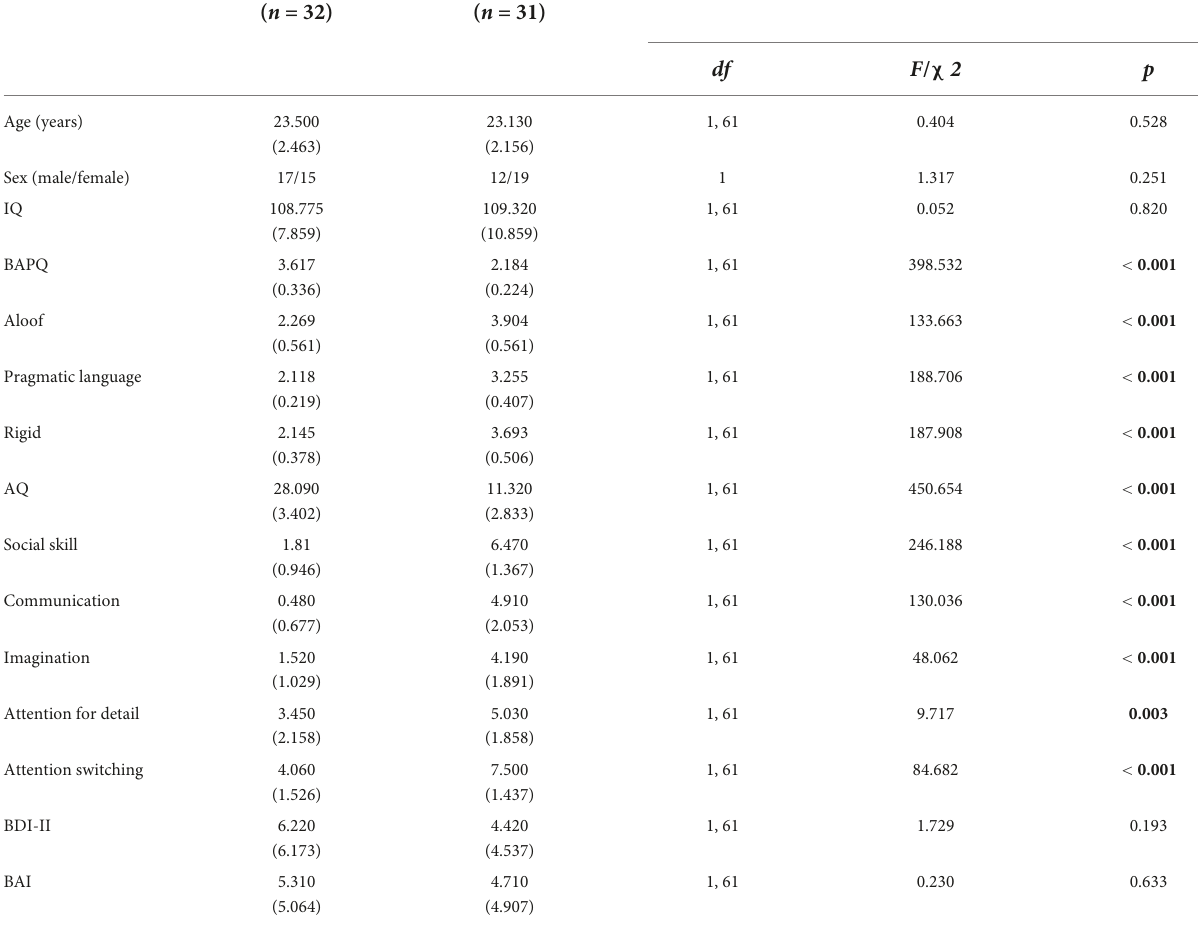
TABLE 1 Demographic and clinical characteristics for each